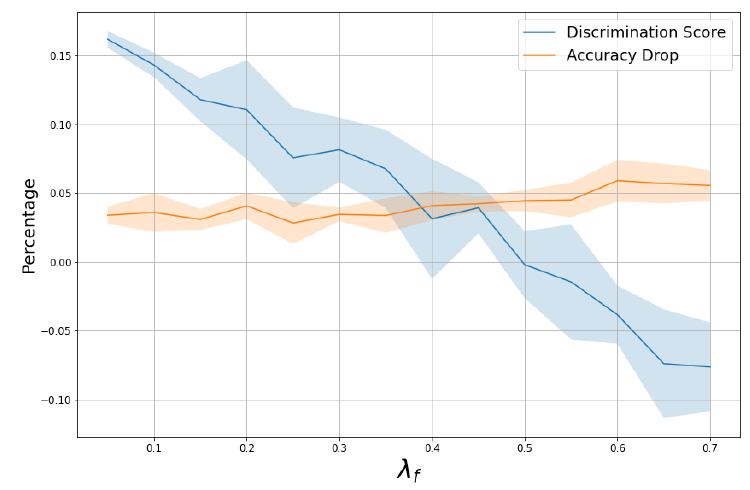
Figure 2. Exploring the trade-off between accuracy and fairness by incremental increasing of parame- ter λ f . Each data point is the average over five trainings, with standard deviation of the five training shown as confidence